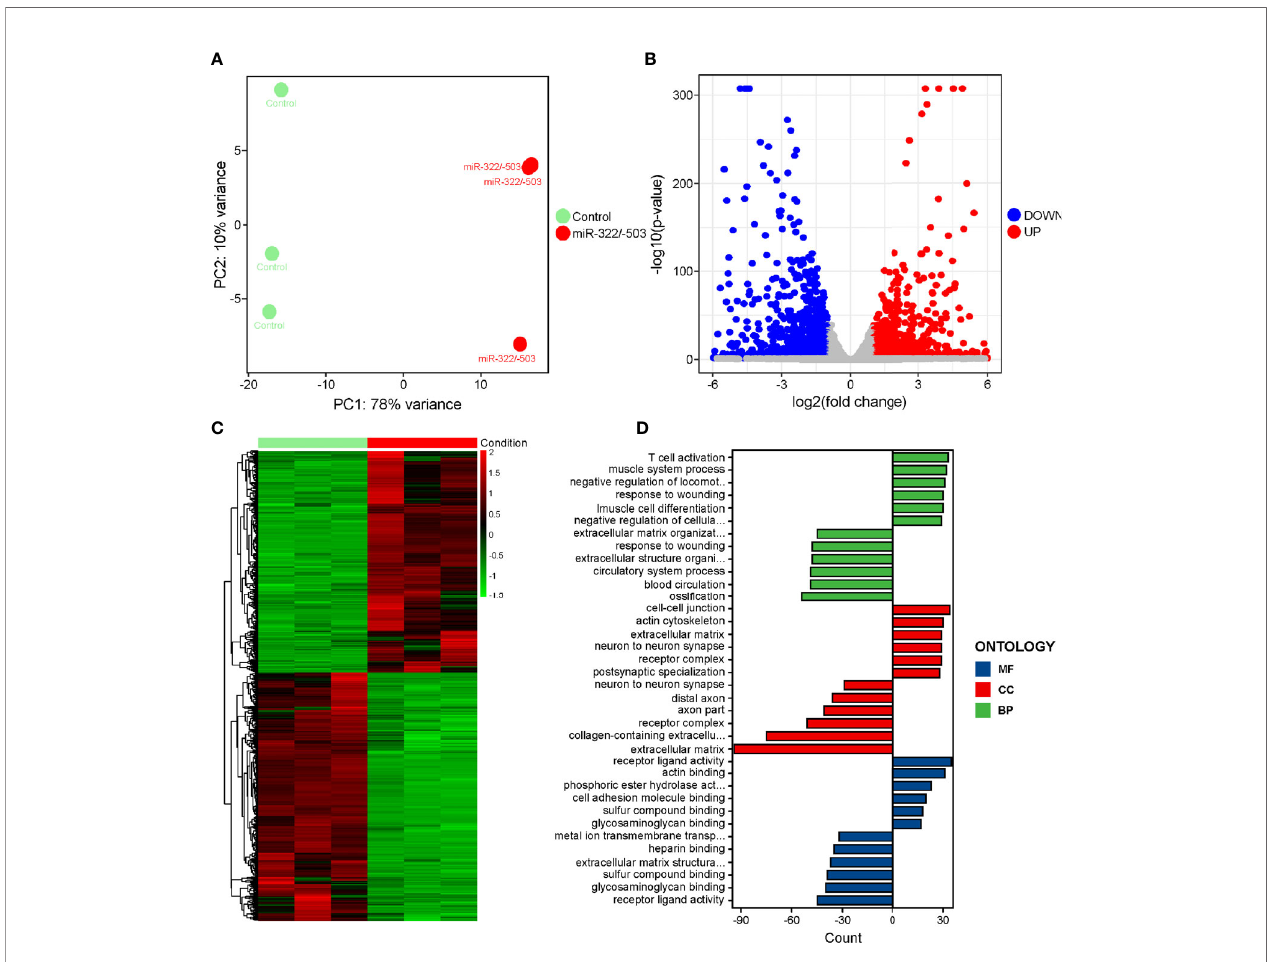
FIGURE 4 | RNA-seq on the differentiating control and miR-322/-503 overexpressing DM1 myoblasts. (A) PCA of the RNA-seq data. There were three replicates for each group. (B) The volcano plot displayed the distribution of DEGs. Red dots represented the signi fi cantly upregulated genes and blue dots represent signi fi cantly downregulated genes. |log 2 (Fold Change)| > 1 and adjusted P-value < 0.05 were used as the cut-off value. (C) Heatmap showed the relative levels of DEGs between the two groups. (D) The GO analysis of DEGs. Control, control empty vector stably transfected DM1 myoblasts; miR-322/-503, miR-322/-503 overexpressing DM1 myoblasts; MF, molecular function; CC, cellular component; and BP, biological process;